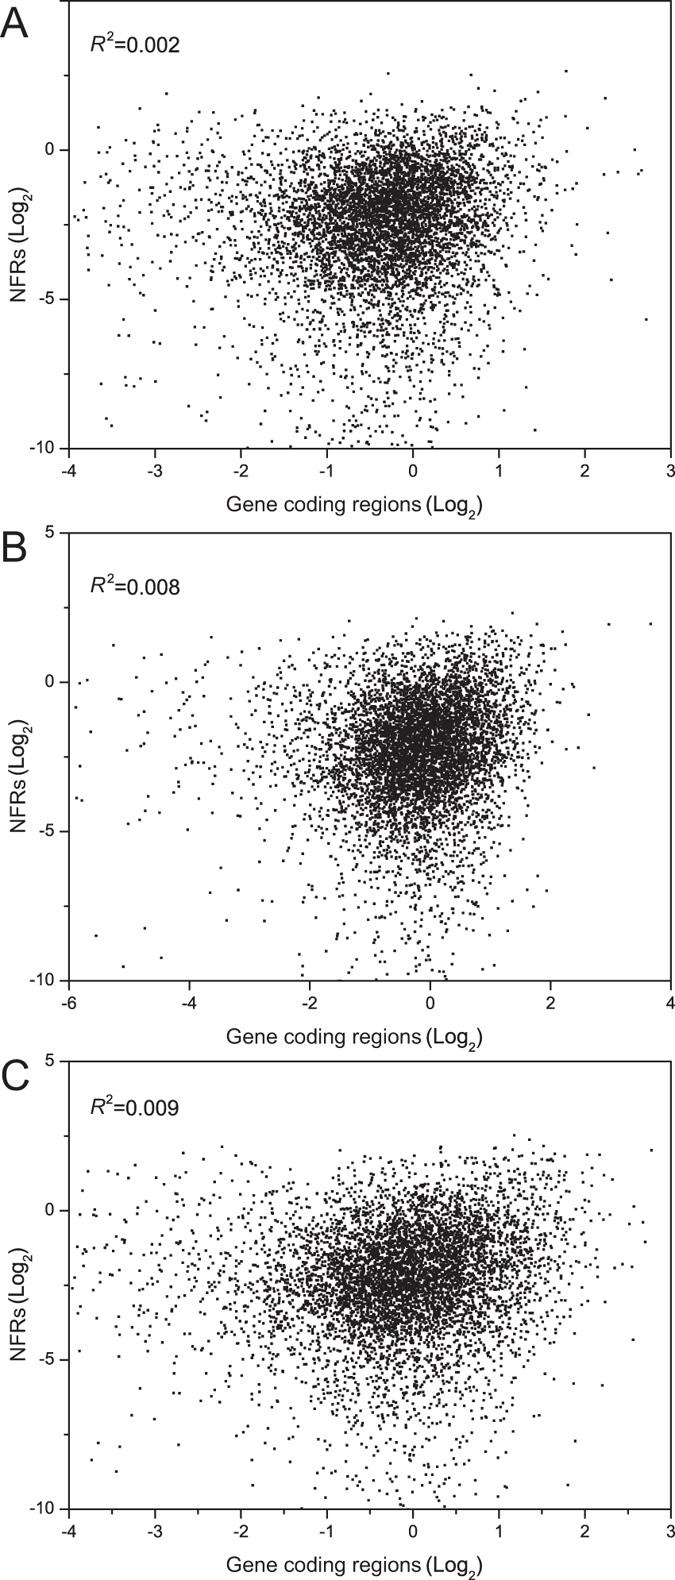
Correlation between nucleosome occupancy at NFRs and gene coding regions.There was no correlation between nucleosome occupancy at NFRs and gene coding regions. The nucleosome occupancy at NFRs were plotted against gene coding regions under three nitrogen conditions, and no correlation was observed with R2 < 0.009. (A) Correlation between nucleosome occupancy at NFRs and gene coding regions in M.Gln medium. (B) Correlation between nucleosome occupancy at NFRs and gene coding regions in M.Pro medium. (C) Correlation between nucleosome occupancy at NFRs and gene coding regions in response to the shift from glutamine to proline for 2 h.